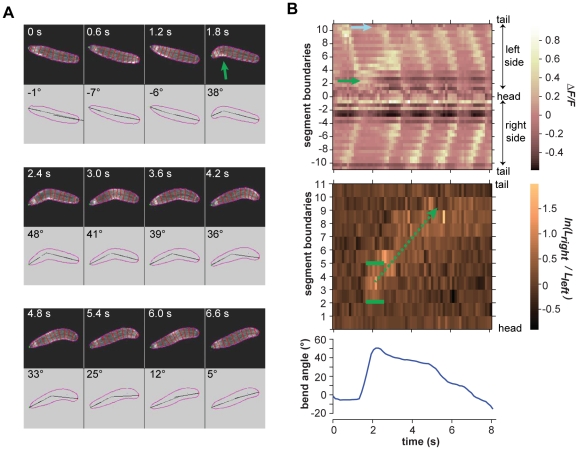
Turning decisions with small head sweeps.
A. Video frames of an example small head sweep during warming. Upper panel in each video frame shows fluorescence image. Outline and boundaries between segments are shown in red. Lower panel in each video frame shows the perimeter, centerline, and body bend angle as analyzed by machine vision software. Green arrow shows the asymmetric bend that is flagged as a head sweep. B.
(Upper panel) Kymograph of fluorescence intensity within body segments for the video segment shown in A. Green arrow shows the increase in fluorescence intensity on the left side of the animal, signifying the leftward head sweep. Blue arrow shows the increase in fluorescence intensity in the A8 segment, signifying the resumption of peristalsis at the tail. (Middle panel) Kymograph of the logarithm of the ratio between the lengths of segment boundaries on the left side and right side of the animal. Green brackets indicate the margins of the region of asymmetric contraction, positive values signifying the leftward bend. Green arrow shows the retrograde progression of the region of asymmetric contraction during the four subsequent peristalsis waves. (Lower panel) Time course of body bend angle, operationally defined to flag reorientation maneuvers as described in Materials and Methods, shows the initial rise that signifies the leftward head sweep and gradual decline as subsequent peristalsis waves straighten the body.